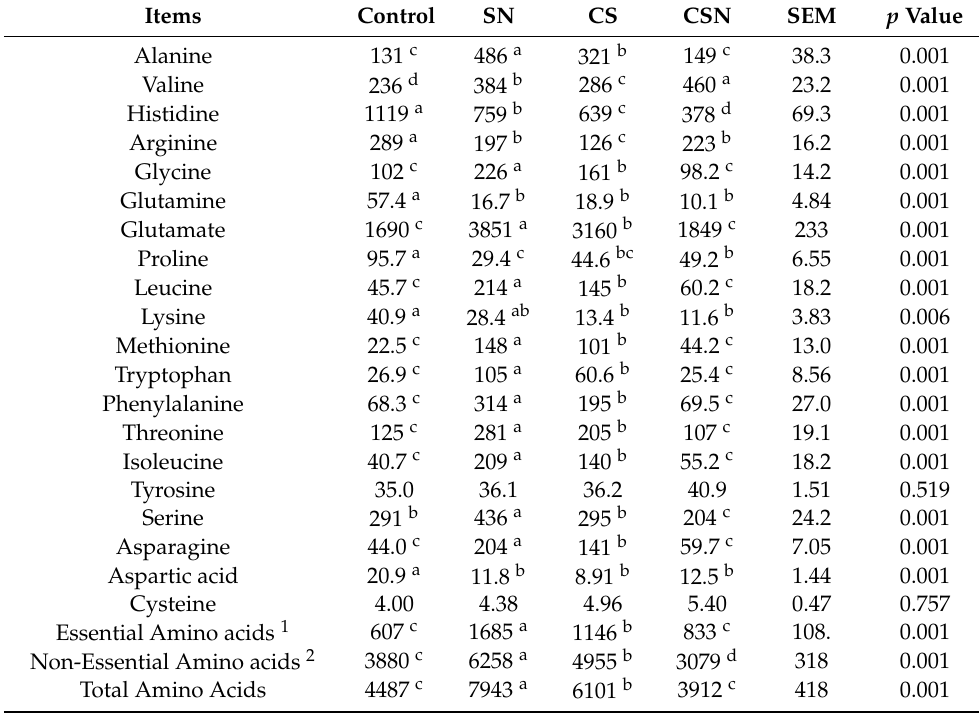
Table 4. Effects of sodium nitrate (SN), cysteamine hydrochloride(CS), and CS and SN (CSN) supplementation on in vitro ruminal batch culture amino acid profile (ng/mL).